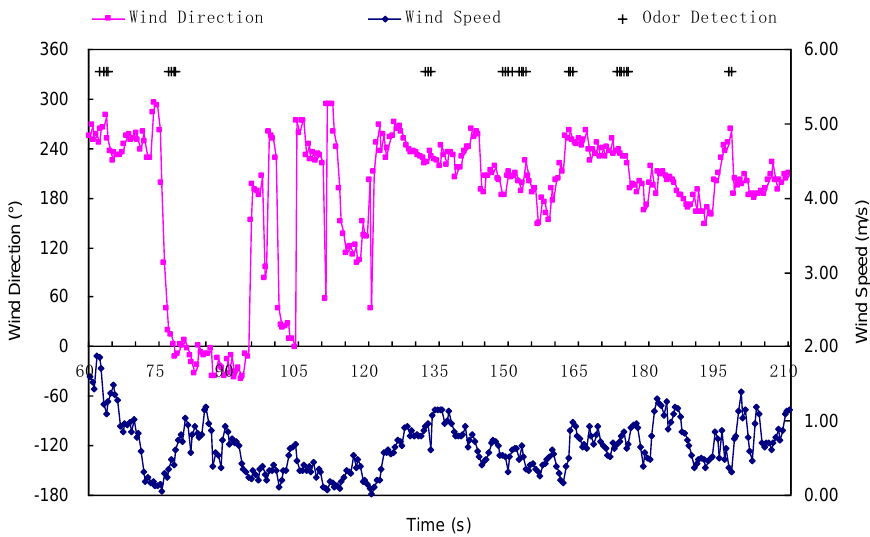
Figure 13. Instantaneous wind directions/speeds and chemical-detection events during the ERP phase shown in Figure 12.